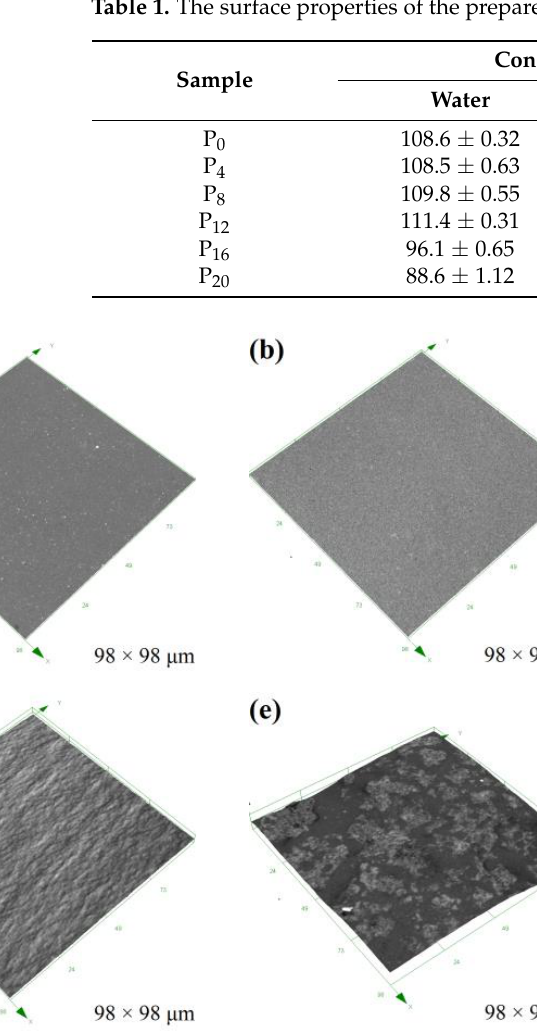
Figure 3. The surface microstructure of the prepared coatings by CLSM. For the P20 sample, the field of view is 640 × 640 µ m, while the field of view for other samples is 98 × 98 µ m. ( a ) P 0 ; ( b ) P 4 ; ( c ) P 8 ; ( d ) P 12 ; ( e ) P 16 ; ( f ) P 20 .